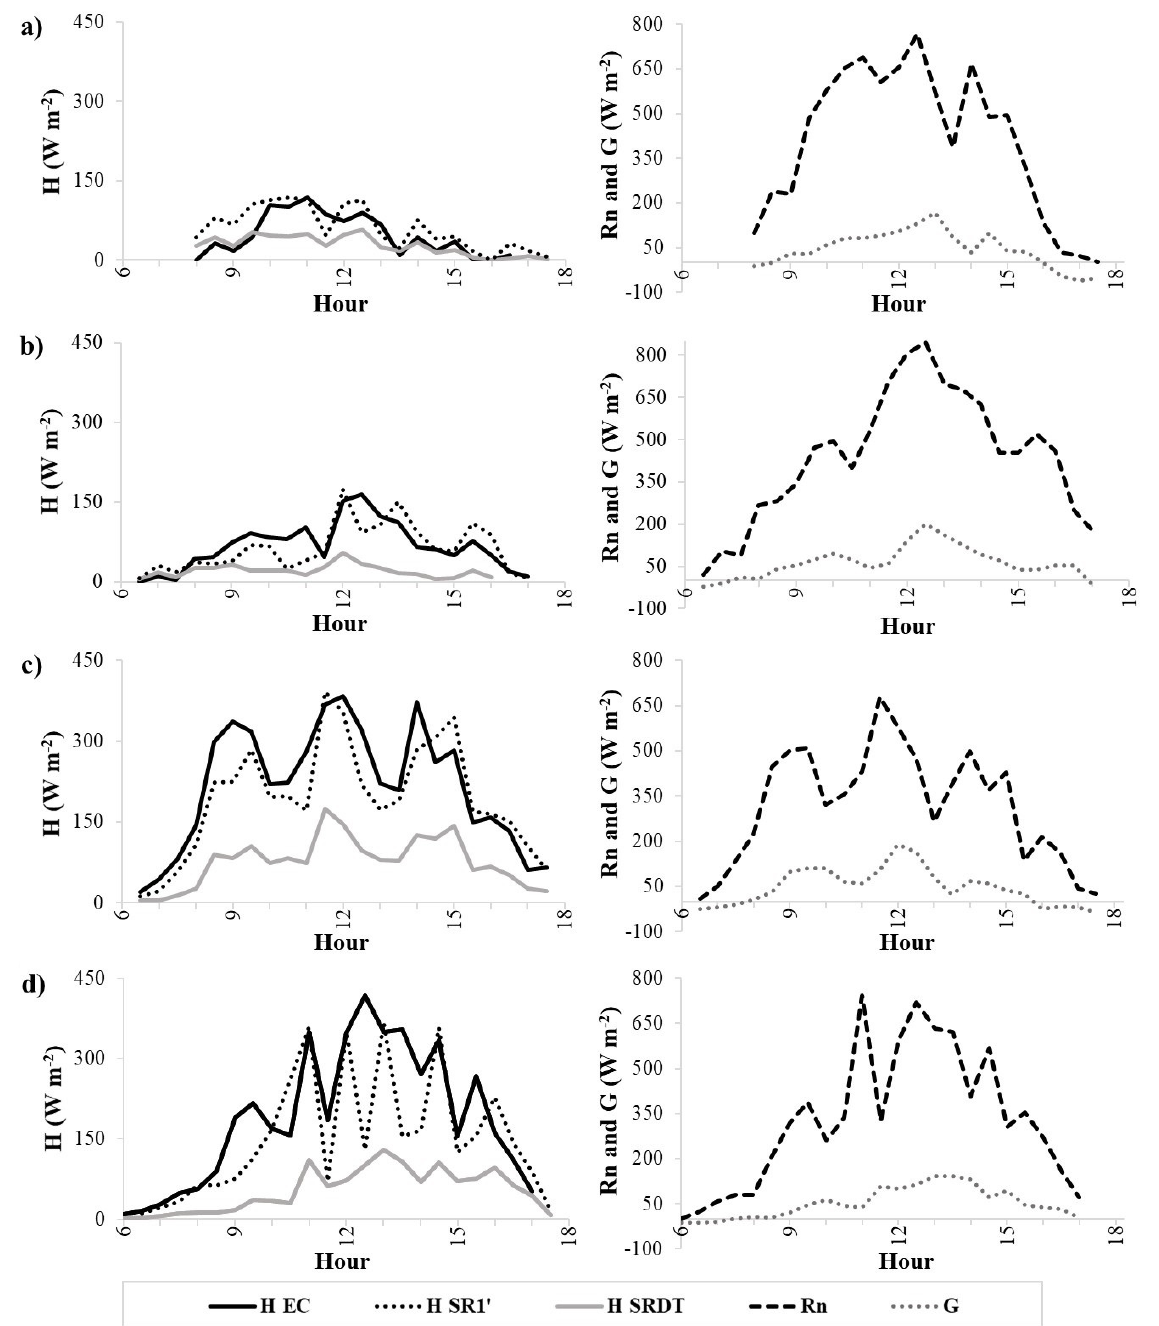
Figure 7 . Diurnal variation of half-hourly H EC , H SR1 ′ , H SRDT , Rn and G for one day during the summer campaign at the ( a ) control and ( b ) cut plot and the spring campaign at the ( c ) control and ( d ) cut plot.